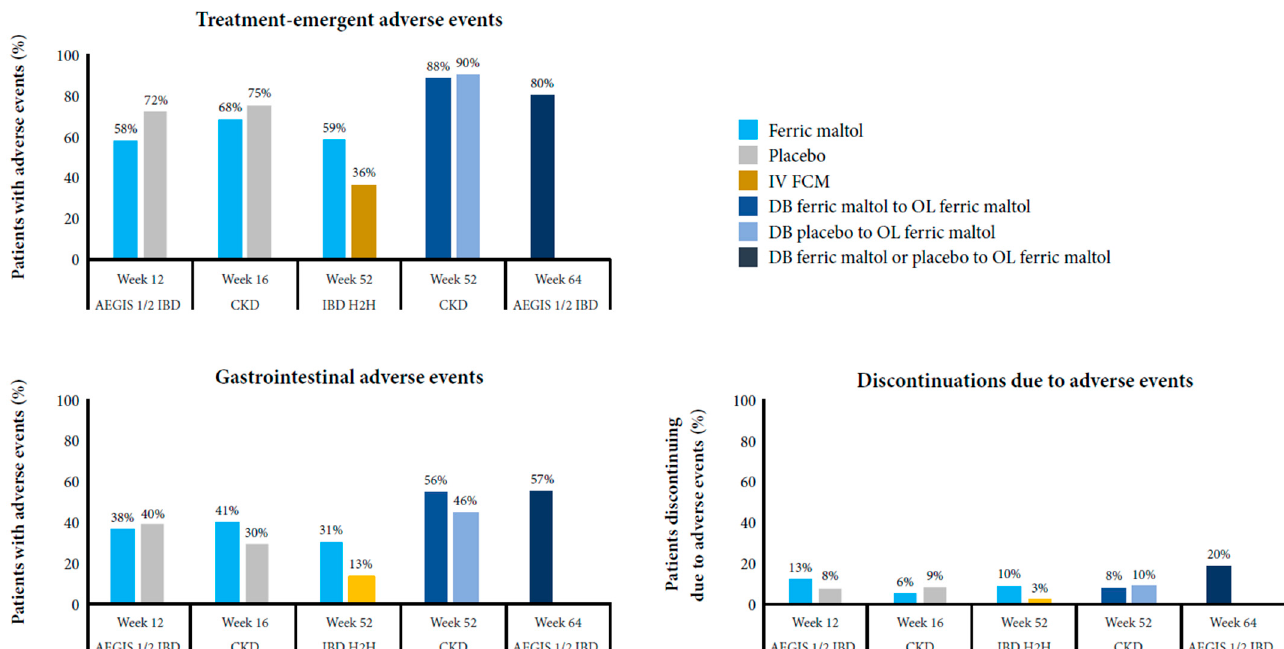
Figure 1. Safety and tolerability of ferric maltol in the long-term phase III studies [62,64,71,72].